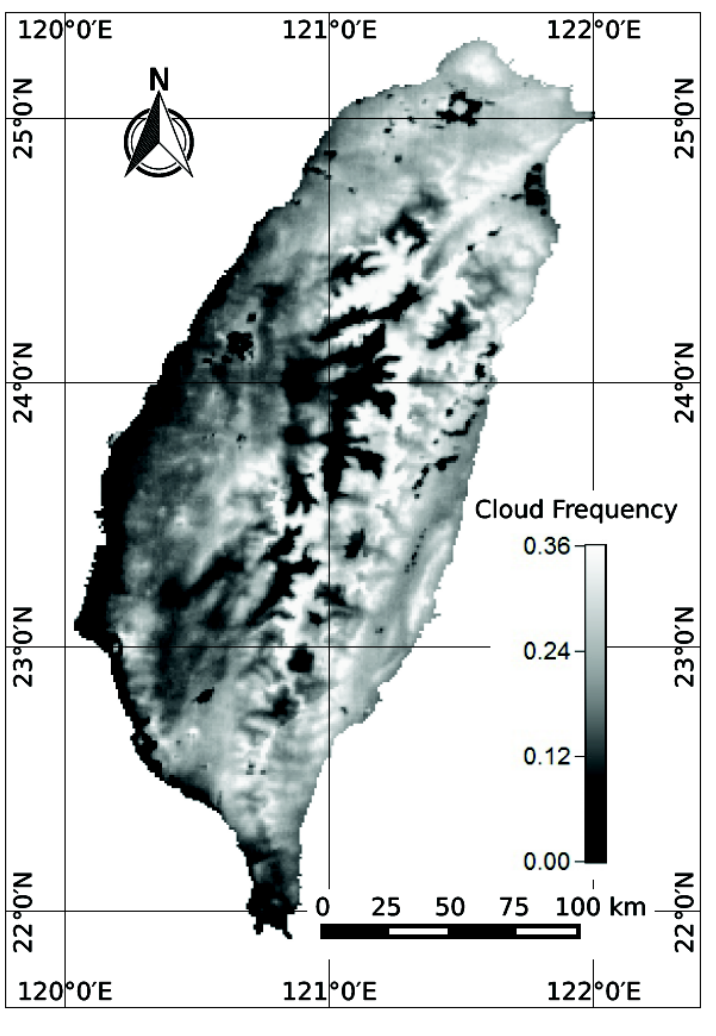
Figure 4. Average daytime (late morning to early afternoon) low cloud frequency over Taiwan based on Terra and Aqua MODIS data from 2003 to